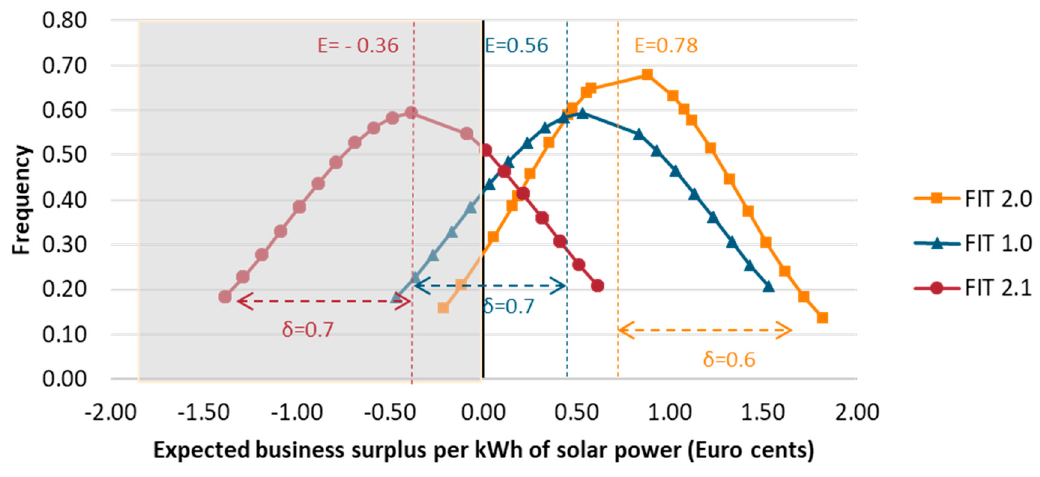
Figure 13. Analyzing the market attractiveness corresponding to the three different FITs.